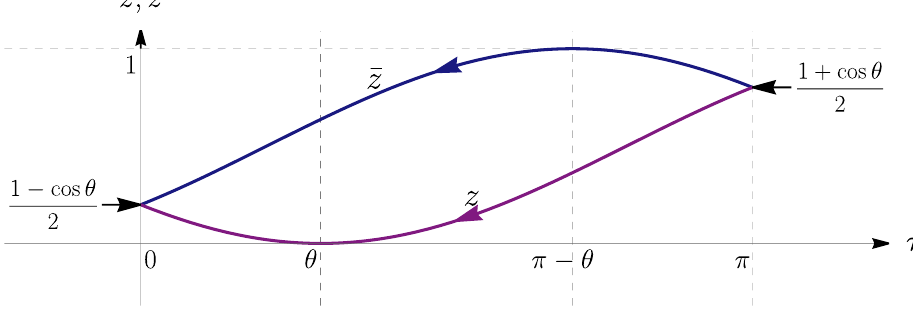
Figure 2 . The evolution of z and ¯ z as τ is decreased from π down to 0 at fixed θ . Note ¯ z touches its maximum value unity at τ = π − θ and z touches its minimum value, z = 0 at τ = θ .